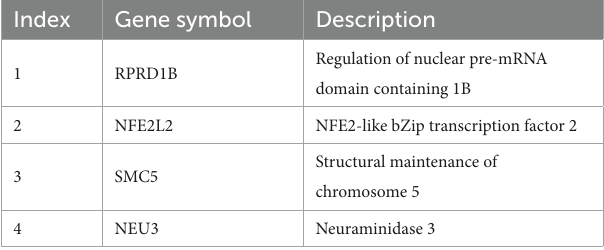
TABLE 5 Essential genes identified by three feature ranking